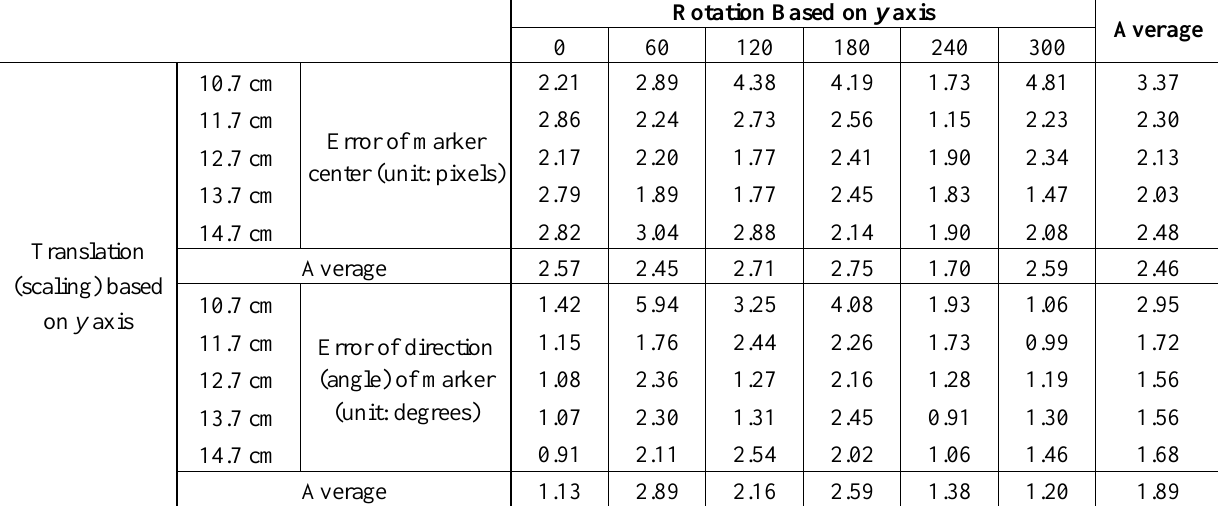
Table 5. Detection error results in case of the translation and rotation of device based on y -axis,